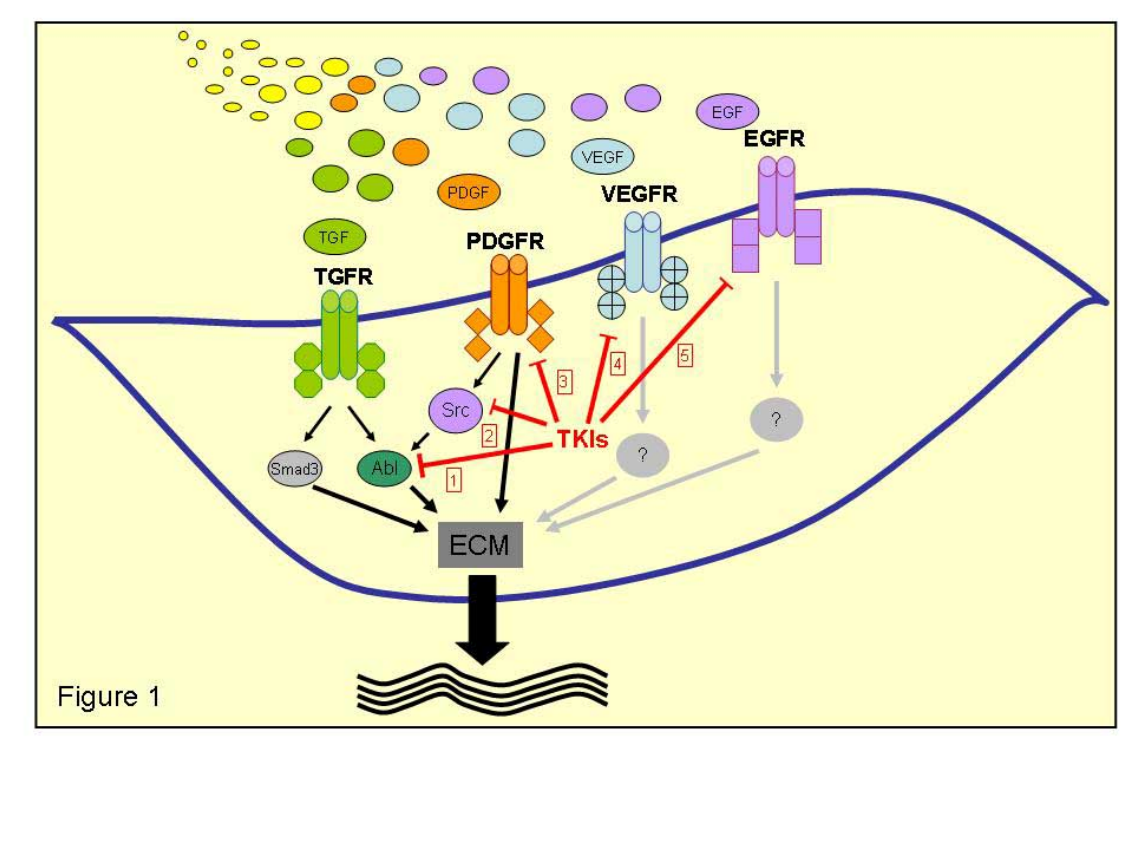
Targeting tyrosine kinases in Systemic